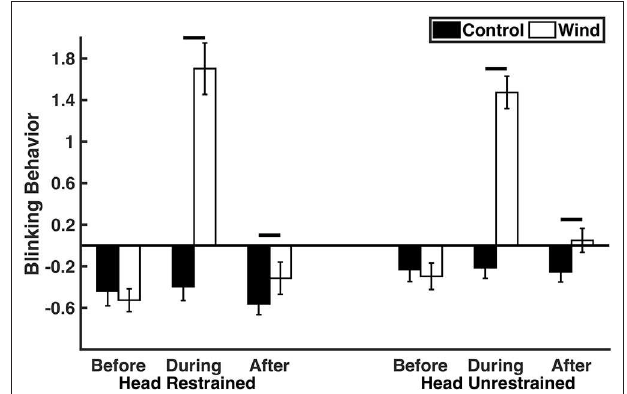
FIGURE 1 | Blinking behavior (composite factor including blink rate, blink duration, and percentage of time spent blinking) before, during, and after the control or wind treatment ( n = 25). Means ± standard errors are displayed. Horizontal lines indicate statistically significant comparisons.